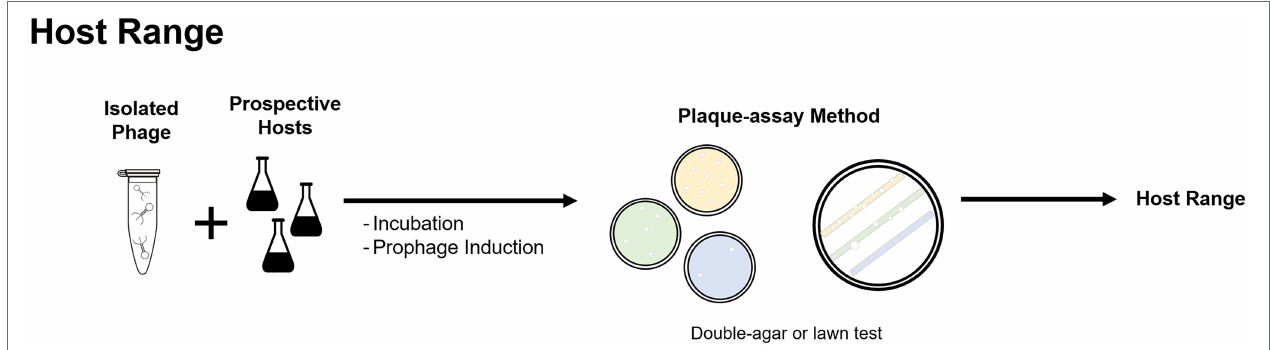
FIGURE 5 | Plaque-assay method can be used to determine the host range of isolated phages by incubating the bacteriophages with selected prospective